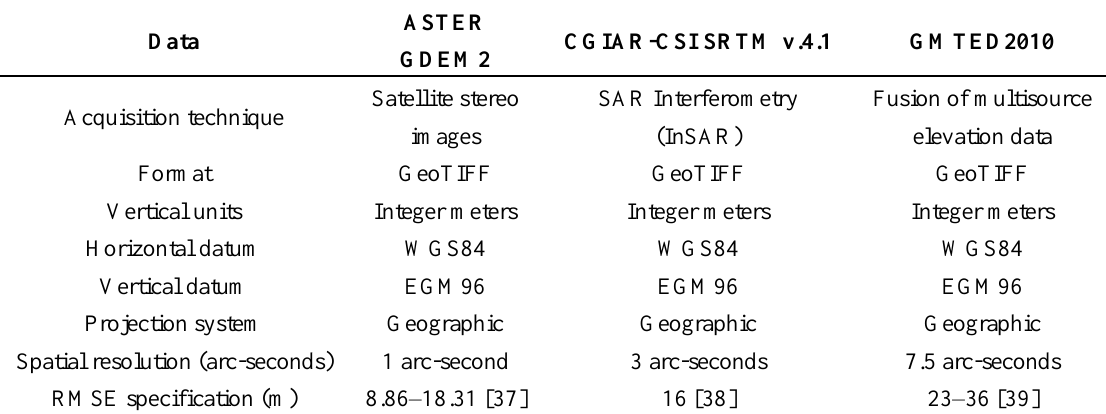
Table 1. Input source data